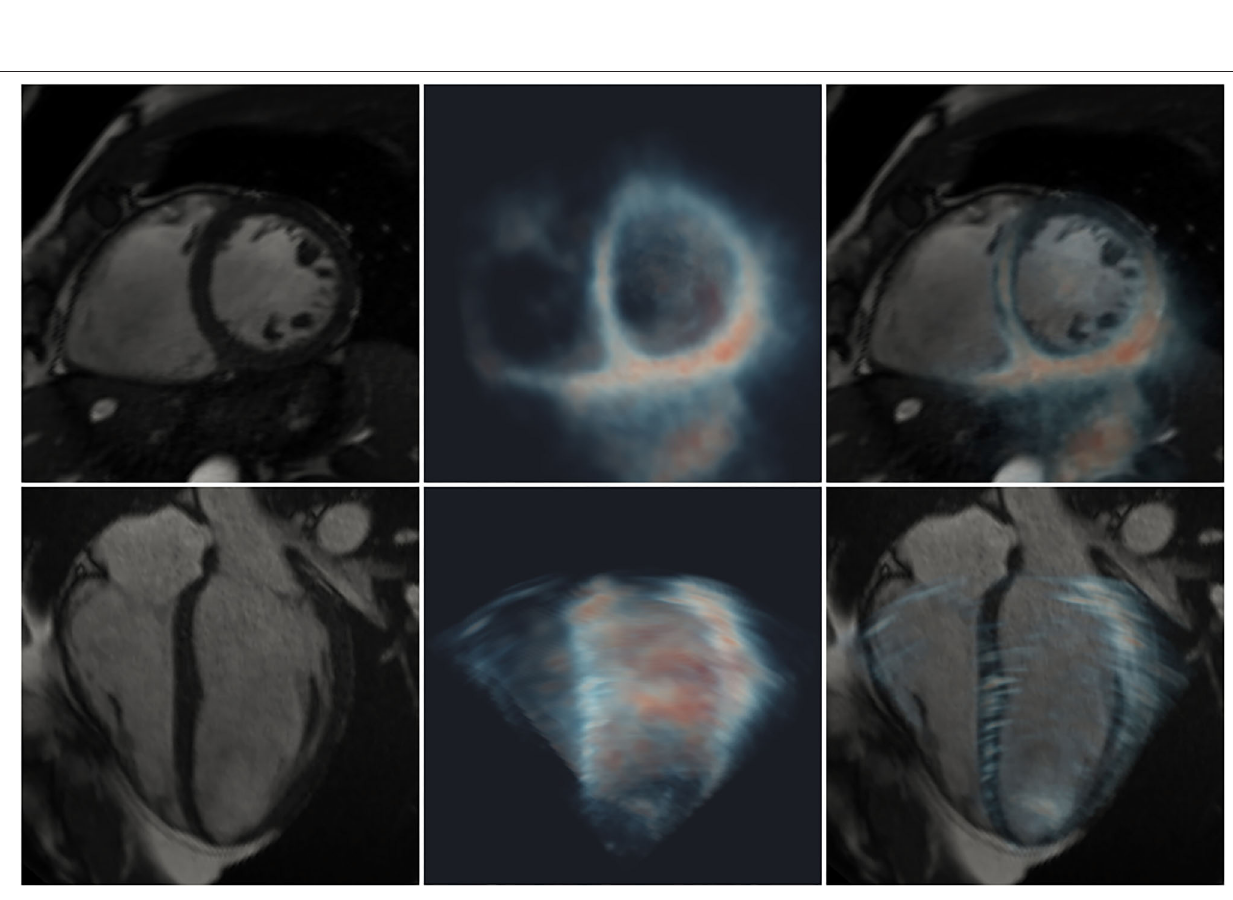
Frontiers in Cardiovascular Medicine |